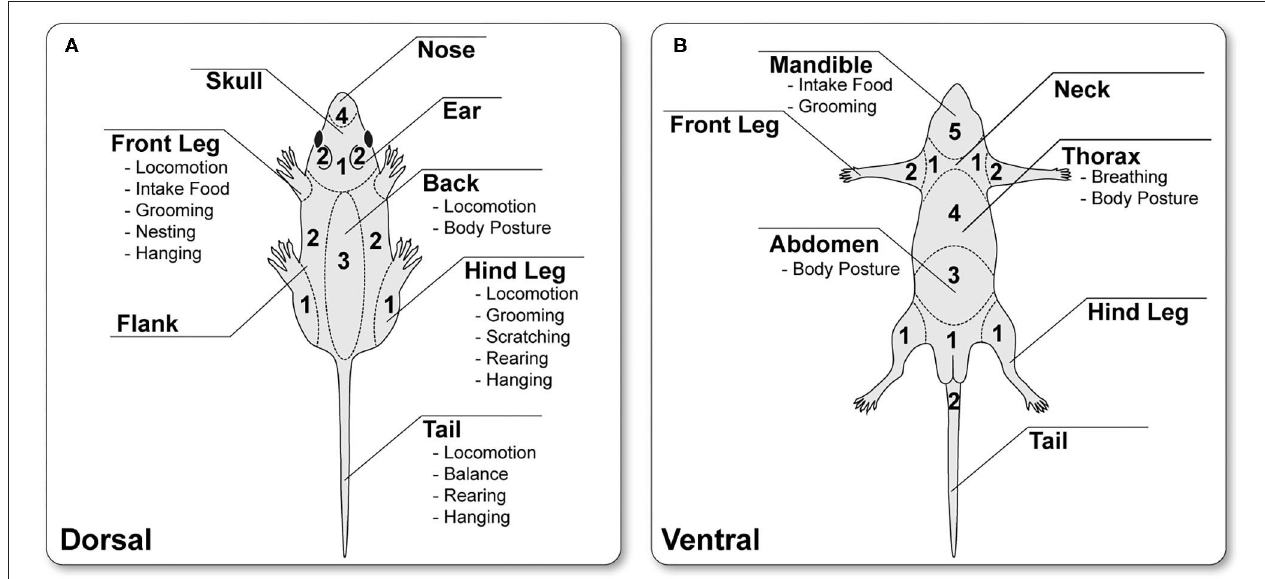
FIGURE 1 | Schematic classification of the dorsal (A) and ventral (B) body surface into 11 different regions, indicated by name and particular biomechanical functions, e.g., movement or maintenance behaviors. The individual body regions are scored between 1 and 5 based on their relevance for the rodent physiological and maintenance. (The illustration was created by modifying images purchased in the PPT Drawing Toolkits-BIOLOGY Bundle from Motifolio,